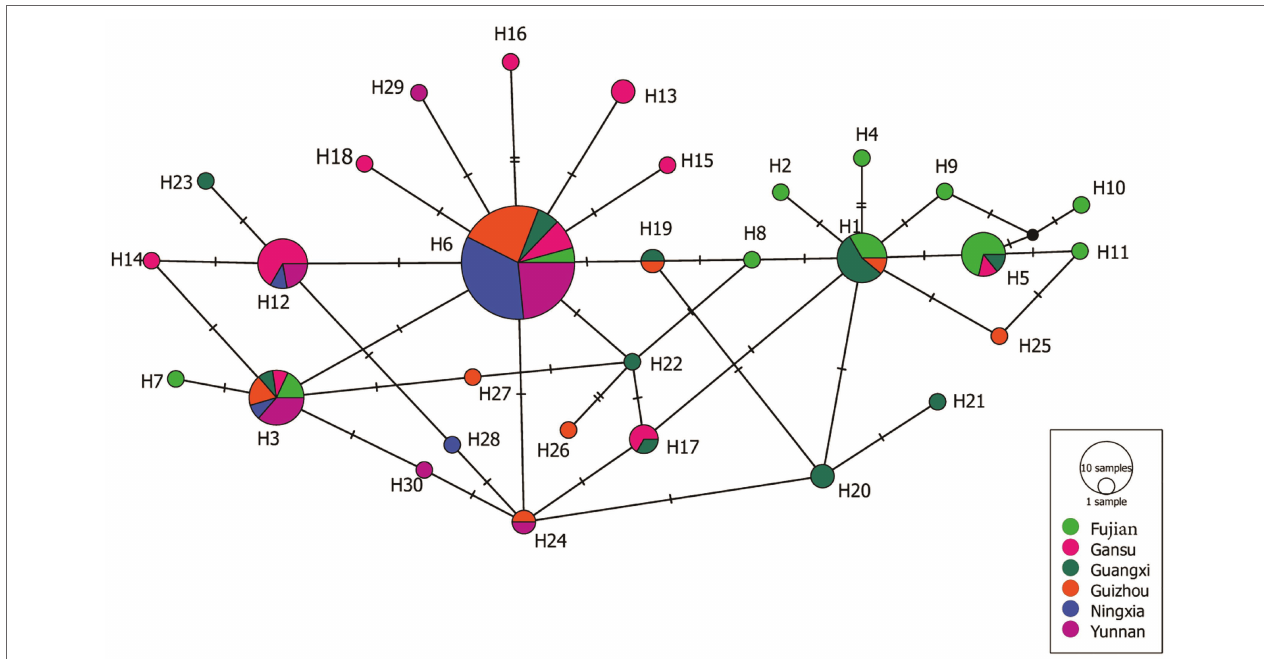
FIGURE 4 | Haplotypes network of the 30 Avr4 nucleotide haplotypes generated from the six P. infestans populations in China. Colors represent geographic origins (populations) of the haplotypes, and circle sizes represent haplotype frequency in the